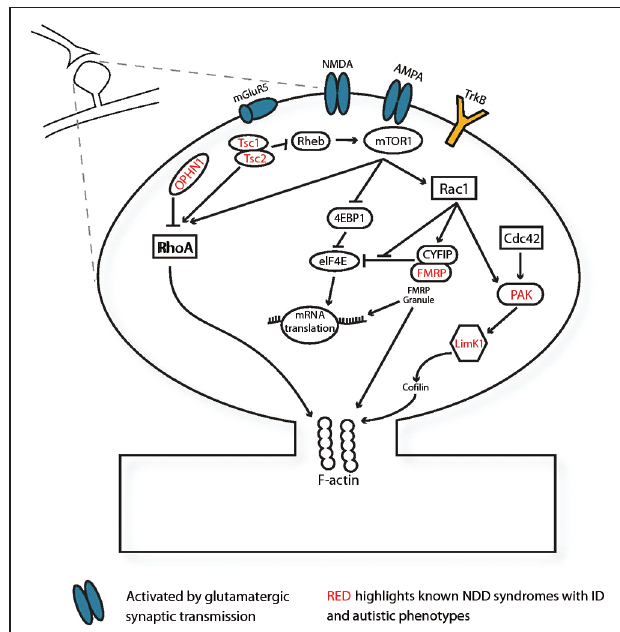
FIGURE 1 | Several NDD-associated genes function at the synapse . Monogenic NDD genes (red) expressed in the synapse, illustrated here postsynaptically, mediate spine morphology changes via small GTPase-mediated signaling pathways and F-actin in response to synaptic activation via BDNF and glutamatergic excitation. Abbreviations: 4EBP1 , eukaryotic translation initiation factor 4E-binding protein 1; AMPA , 2-amino-3-(3-hydroxy-5-methyl-isoxazol-4-yl) propanoic acid receptor; Cdc42 , cell division cycle 42; CYFIP , cytoplasmic binding partner of fragile X protein; eIF4E , eukaryotic translation initiation factor 4E; FMRP , fragile X mental retardation protein; LimK1 , LIM domain kinase 1; mGluR5 metabotropic glutamate receptor subunit 5; mTOR1 , mammalian target of rapamycin 1; NMDA , N-Methyl-D-aspartic acid or N-Methyl-D-aspartate Receptor; OPHN1 , oligophrenin-1; PAK , P21-activated kinase; Rac1 , ras-related C3 botulinum toxin substrate; Rheb , Ras homolog enriched in brain; RhoA , ras homolog gene family, member A; TrkB , TrkB tyrosine kinase; Tsc 1 , tuberous sclerosis protein 1; Tsc 2 , tuberous sclerosis protein